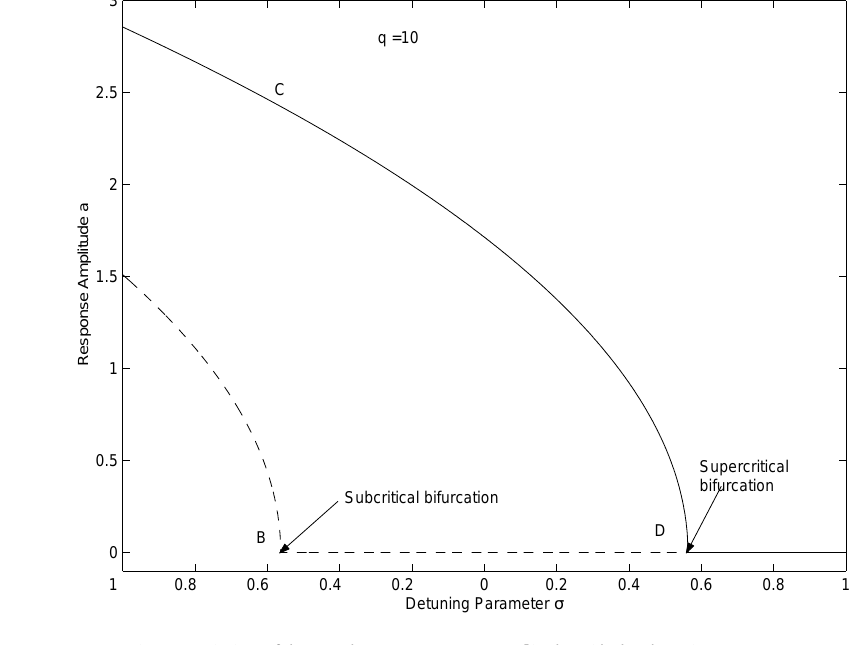
Fig. 2. Variation of the steady-state response amplitude with the detuning